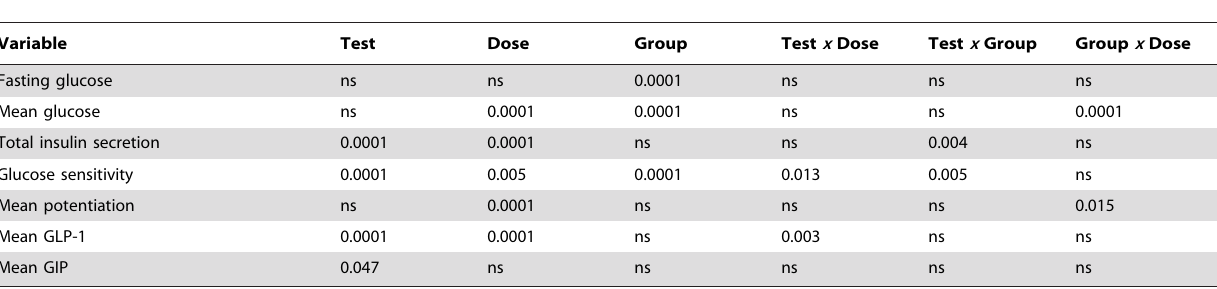
Table 2. Statistical significance of differences by test, dose, and group (ANOVA for doubly repeated measures)*.